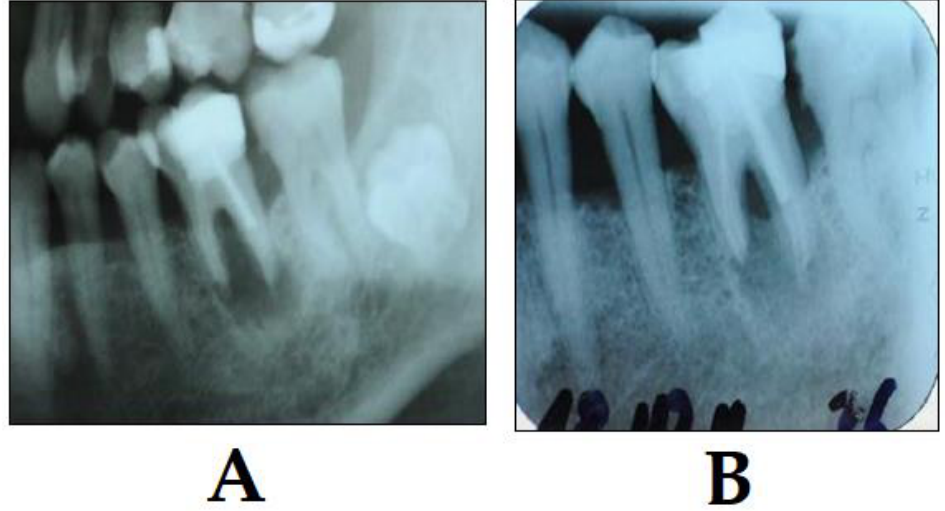
Figure 6. Example of PDT in periodontal therapy (photo courtesy of R. Szabó DMD, J. Arentz DMD and T. Nave DMD). ( A ) X-ray shows a perio-endo lesion of a tooth before PDT; and ( B ) X-ray shows the condition three months after PDT. Bone regeneration is visible showing clear signs of clinical improvement.